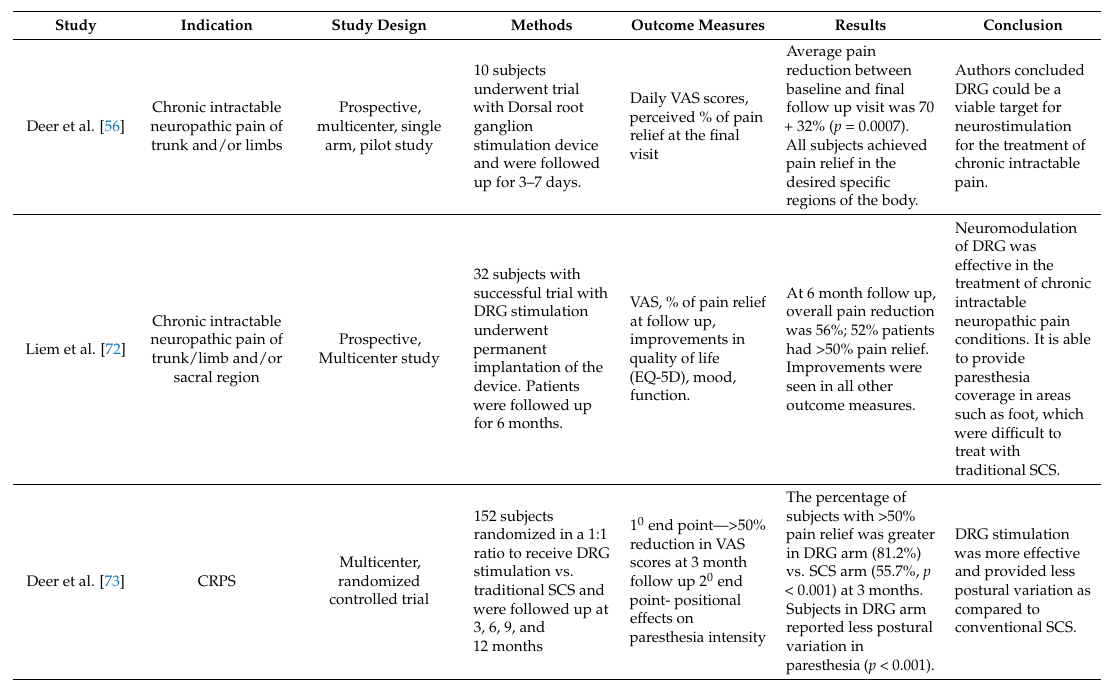
Table 4. Evidence for efficacy for DRG